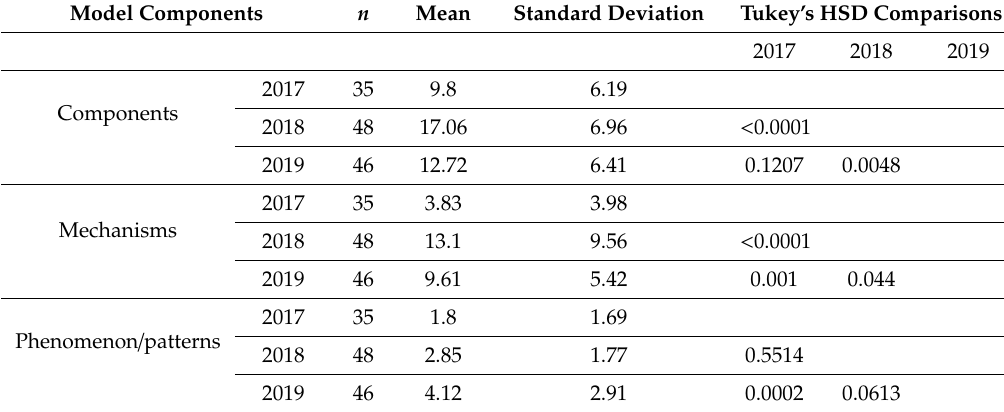
Table A3. Model and article rubric component mean, standard deviation, and Tukey’s HSD for 2017, 2018, and